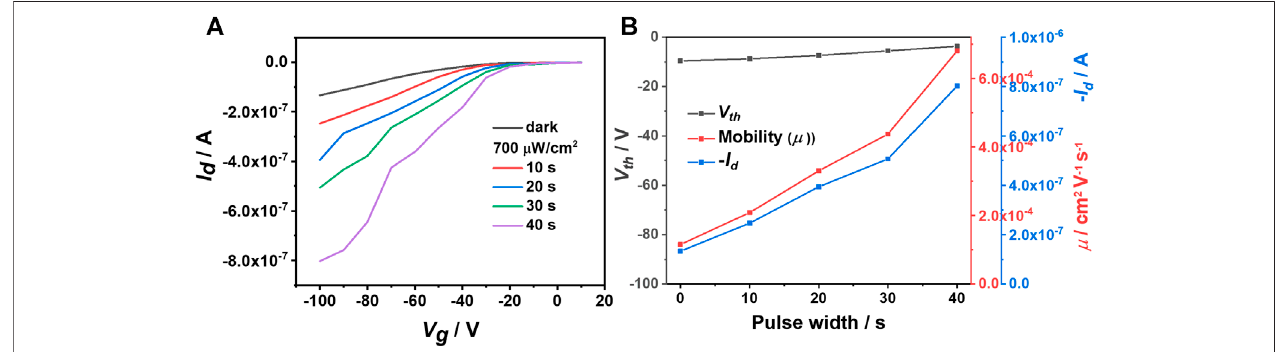
FIGURE 3 | (A) Transfer curves of IDTOT-4F based optoelectrical devices under illumination with different pulse widths ( V d (cid:2) − 100 V); (B) Source-drain currents, threshold voltages ( V th ) and mobilities ( μ ) vs. light pulse widths.